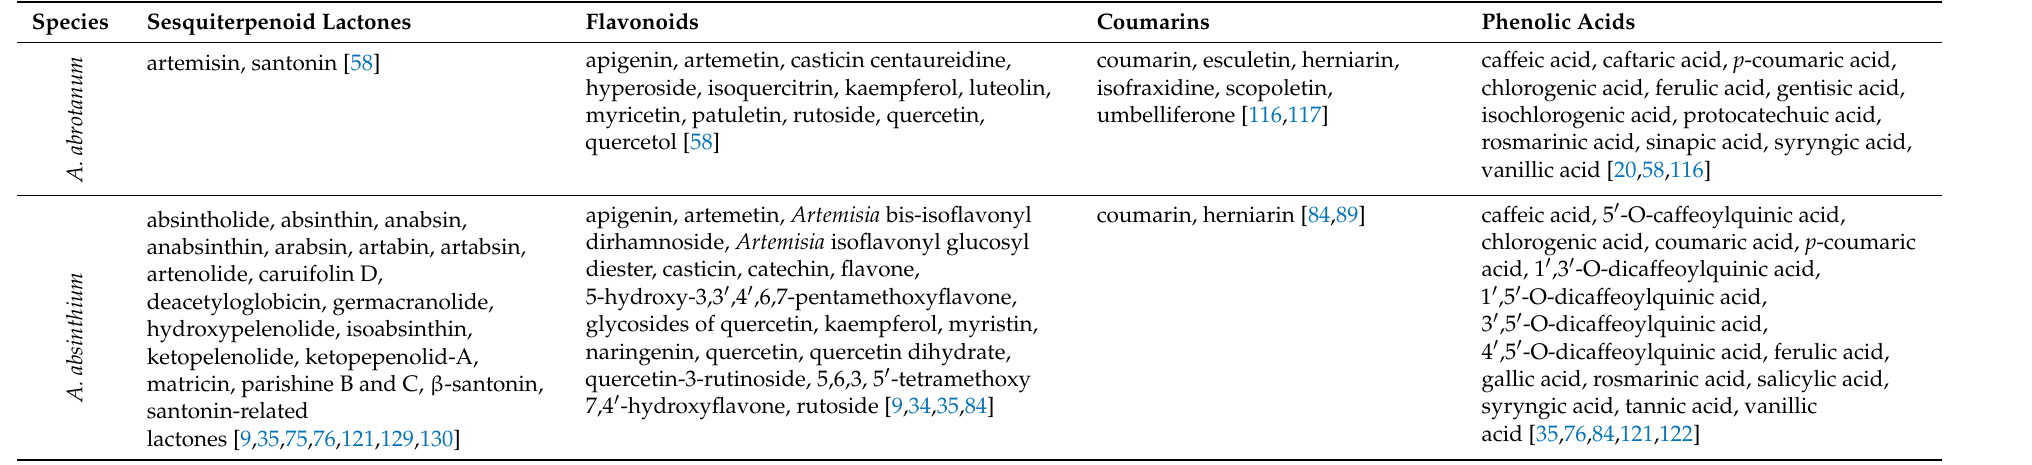
Table 2. Chemical composition of extracts from aerial parts of Artemisia